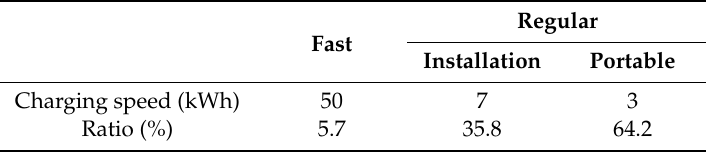
Table 18. Information about each charging